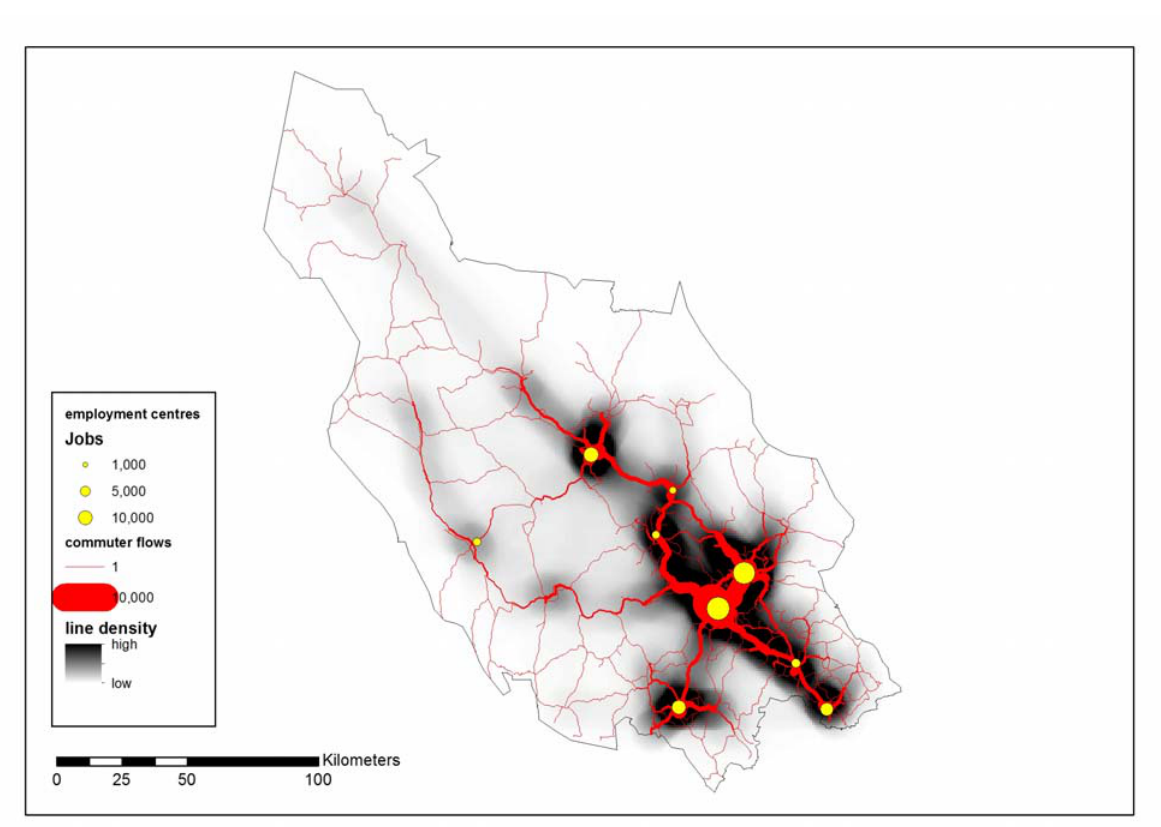
Figure 12. Commuter flows on road network and line